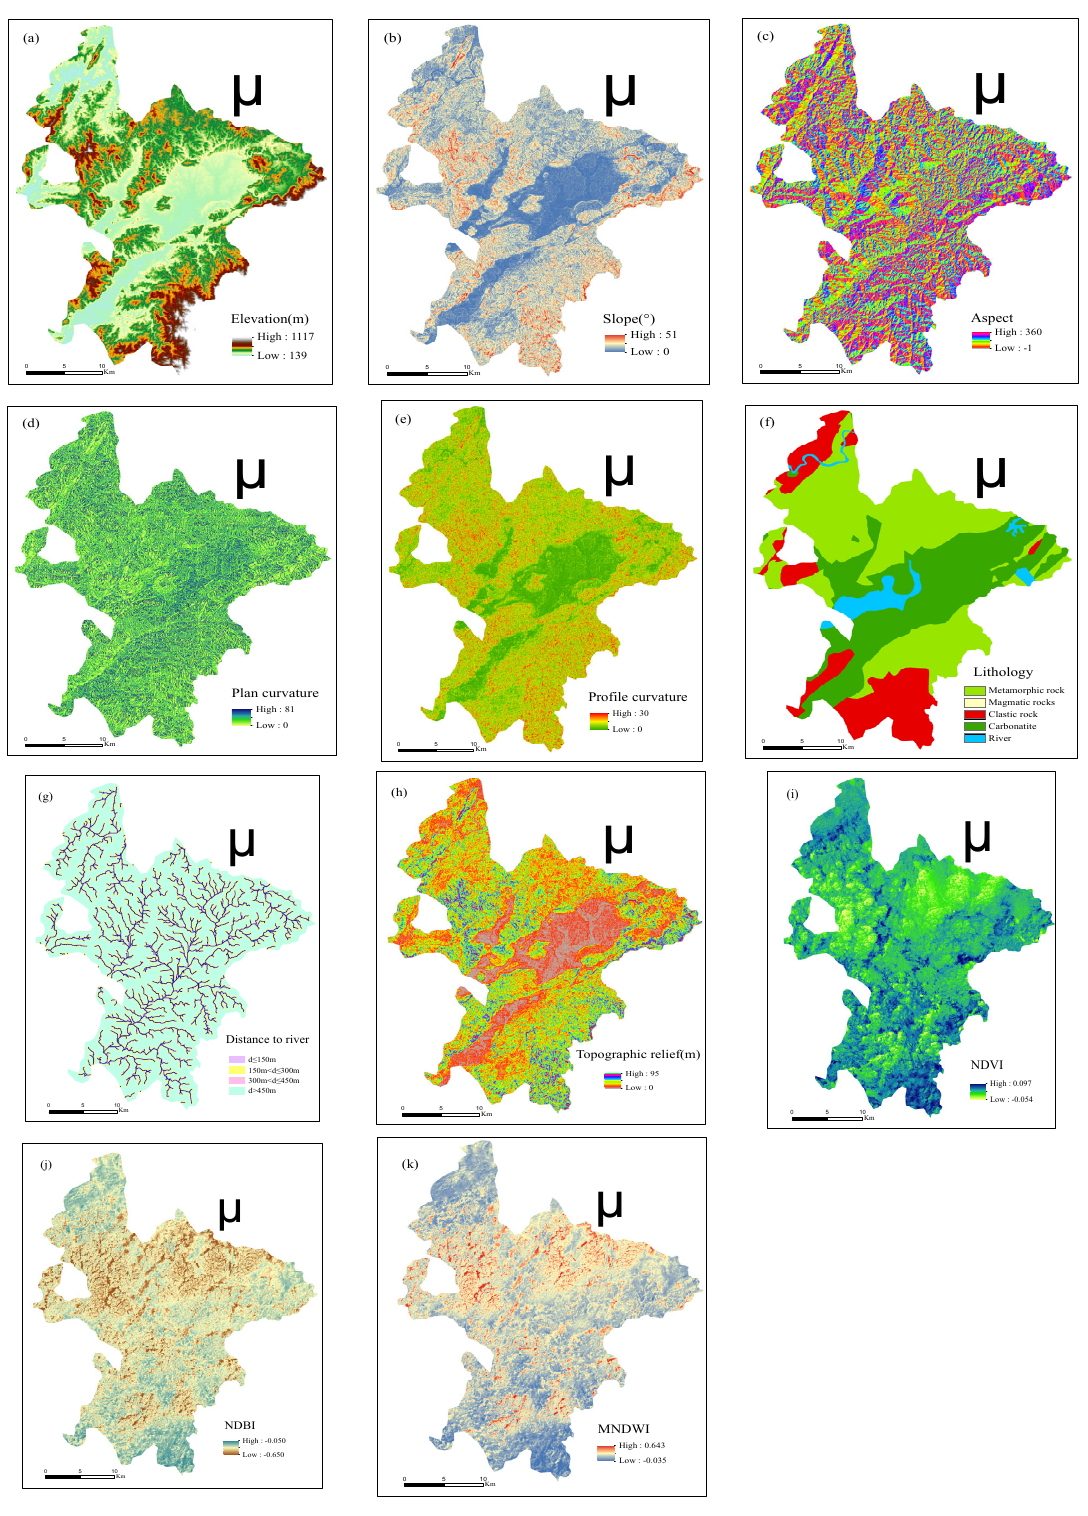
Figure 4. The topographical factors, land cover, hydrology, and geological factors: ( a ) Elevation, ( b ) Slope, ( c ) Aspect, ( d ) Plan curvature, ( e ) Pro fi le curvature, ( f ) Lithology, ( g ) Distance to river, ( h ) Topographic relief, ( i ) NDVI, ( j ) NDBI and ( k )MDWI . Table 2. Frequency ratio of topographical factors.